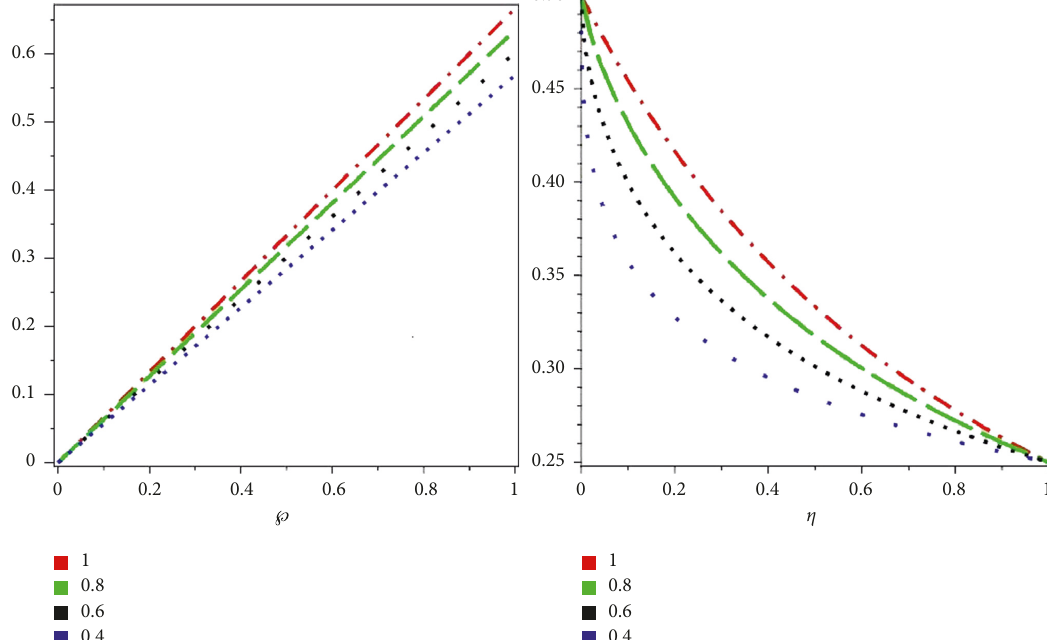
Figure 1: First figure show that the analytic result of various fractional-order of problem 1 and second graph with respect to time.